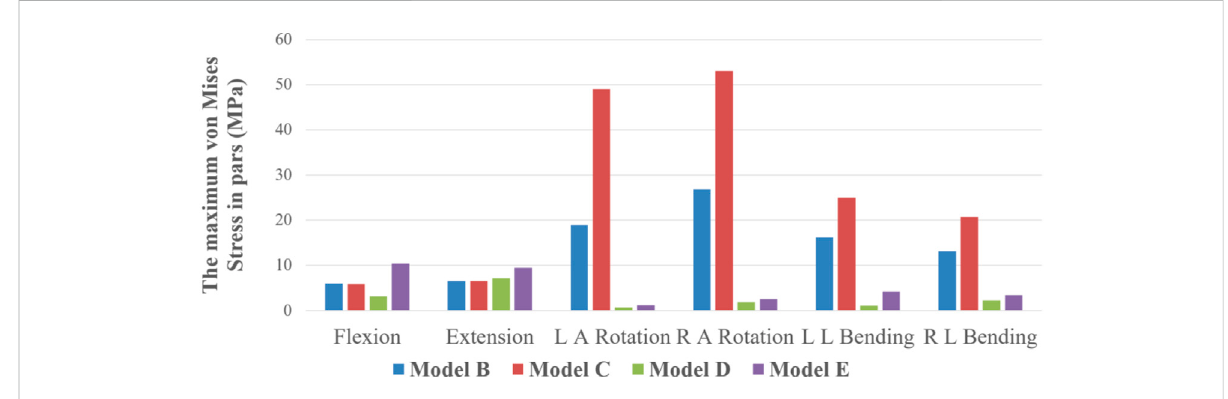
FIGURE 7 The maximum von Mises Stress on pars interarticularis of Model B, C, D, and E under six states of